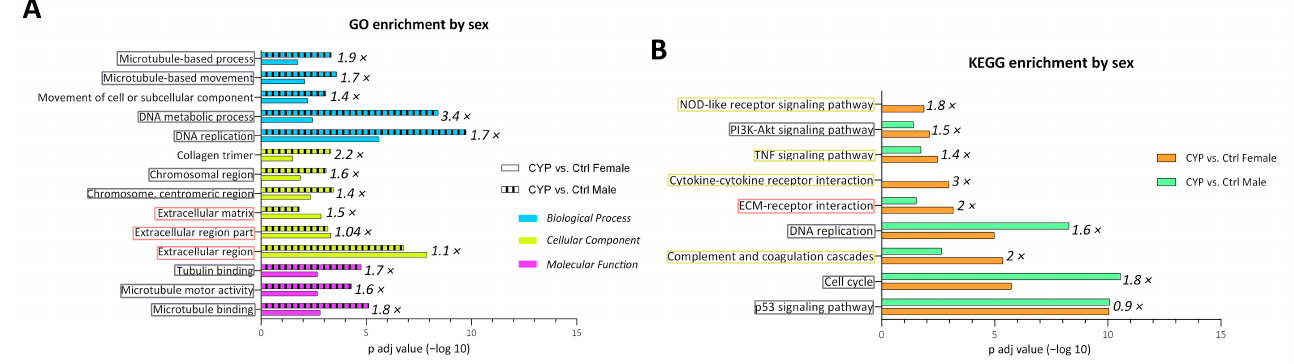
Figure 6. The CYP-induced enrichment of different processes is sex-specific. ( A ) GO enrichment analysis showing significantly enriched biological processes (blue), cell components (yellow), and molecular functions (green). Represented are − log10 p adj values for each process, comparing CYP males (dashed bars) and CYP females (empty bars). Numbers at the end of each bar represent the fold change between CYP males and CYP females in the p adj value of each enriched process. ( B ) KEGG enrichment analysis showing significantly enriched pathways ( − log10 of p adj) comparing CYP males (green bars) and CYP females (orange bars). Numbers at the end of each bar represent the fold change between CYP males and CYP females in the p adj value of each enriched process. Processes involved in cell proliferation are circled in gray; processes of cell-extracellular space com- munication are circled in pink; and processes of innate immunity are circled in yellow.